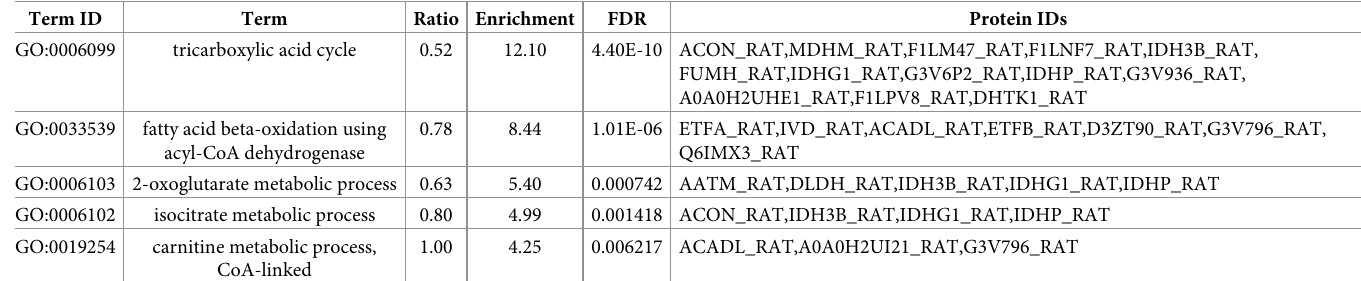
Table 2. The significantly enriched GO terms related to biological